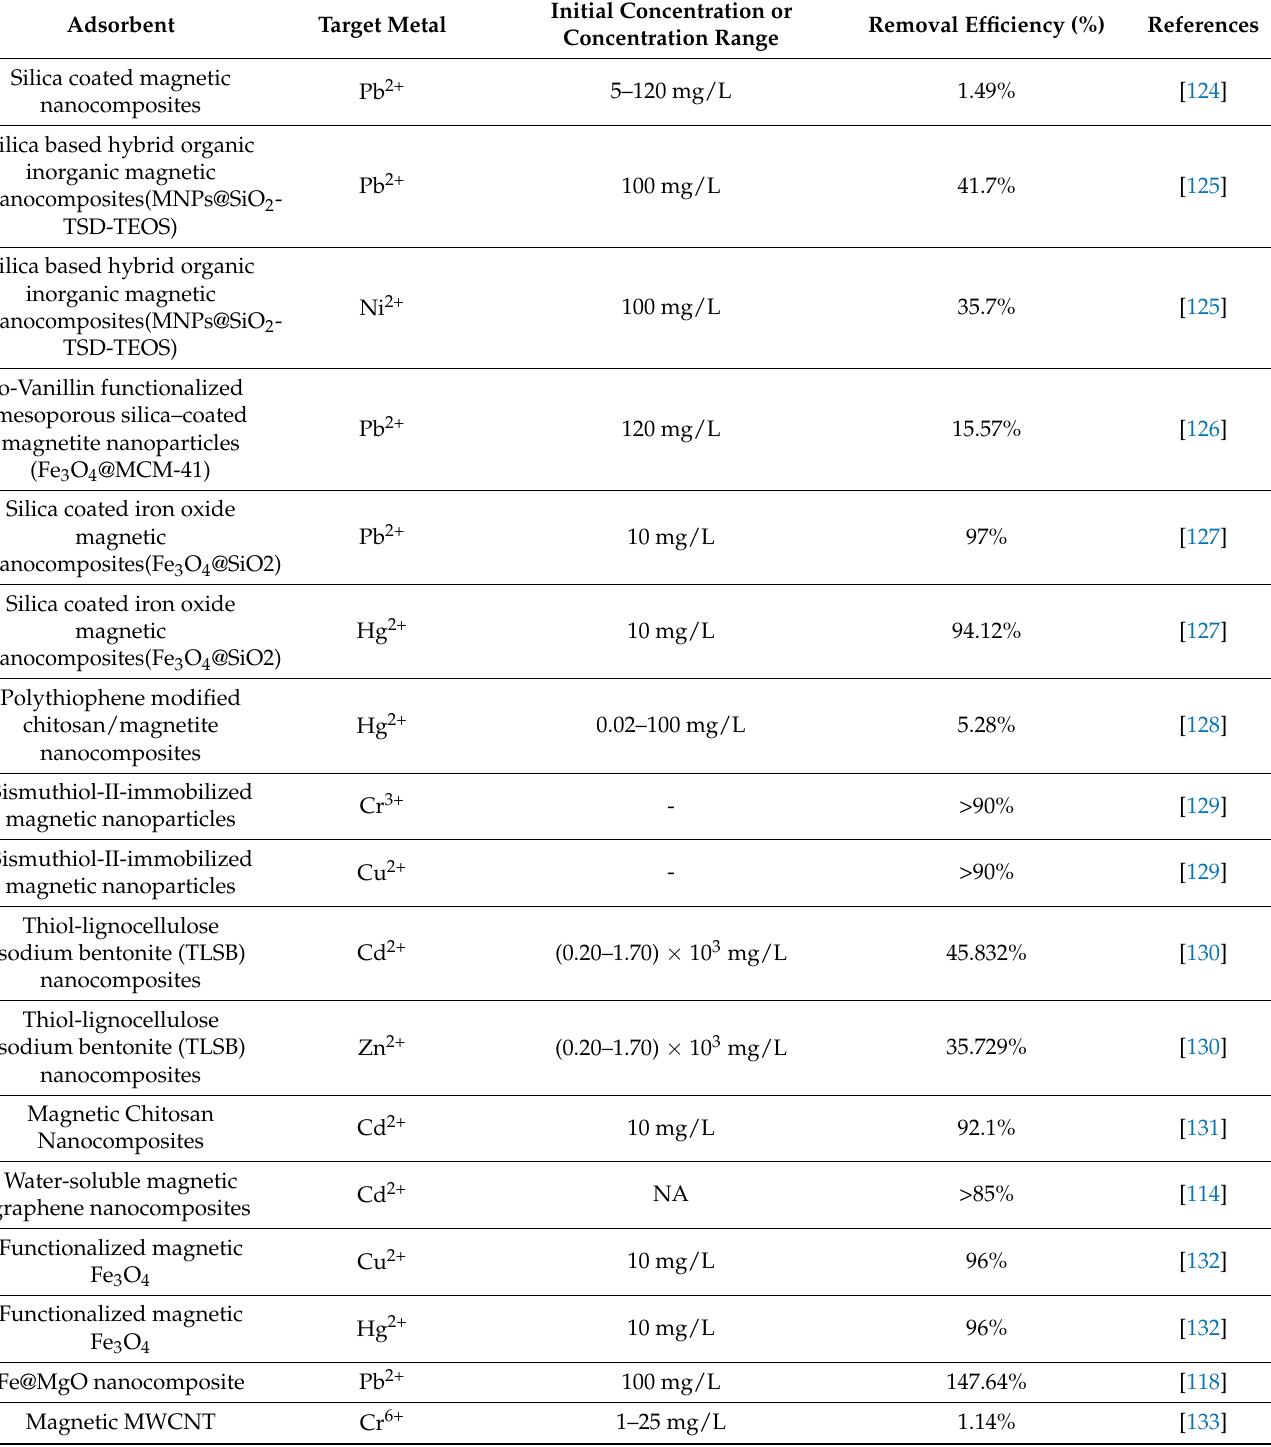
Table 6. Summary of the removal studies on heavy metals using magnetic